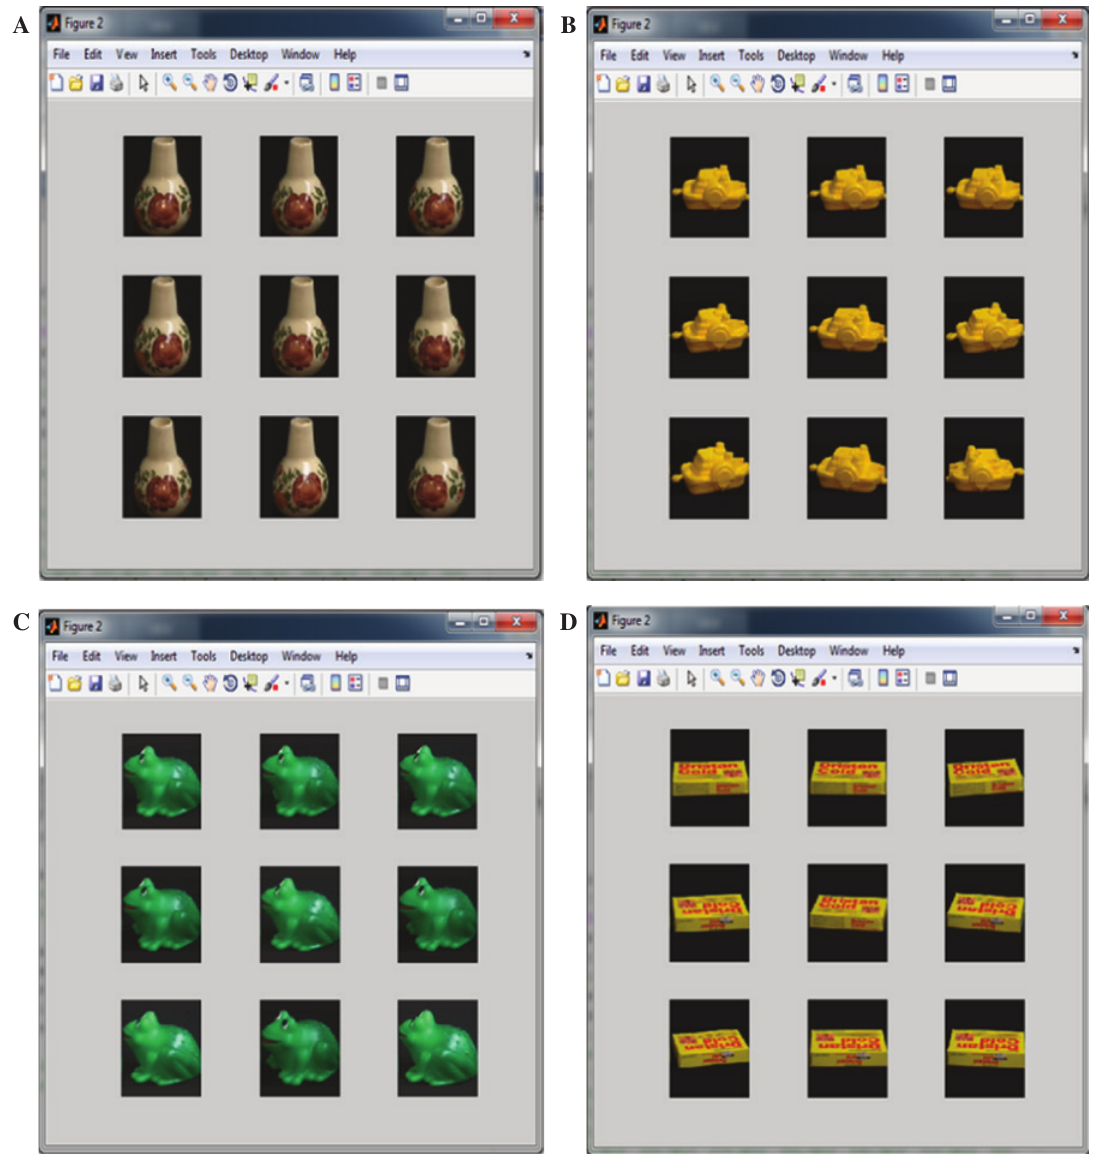
Figure 8: The Relevant Objects Retrieved from the Database for the First Image as the Query Image. (A) Relevant objects retrieved for category 1. (B) Relevant objects retrieved for category 4. (C) Relevant objects retrieved for category 9. (D) Relevant objects retrieved for category 2.